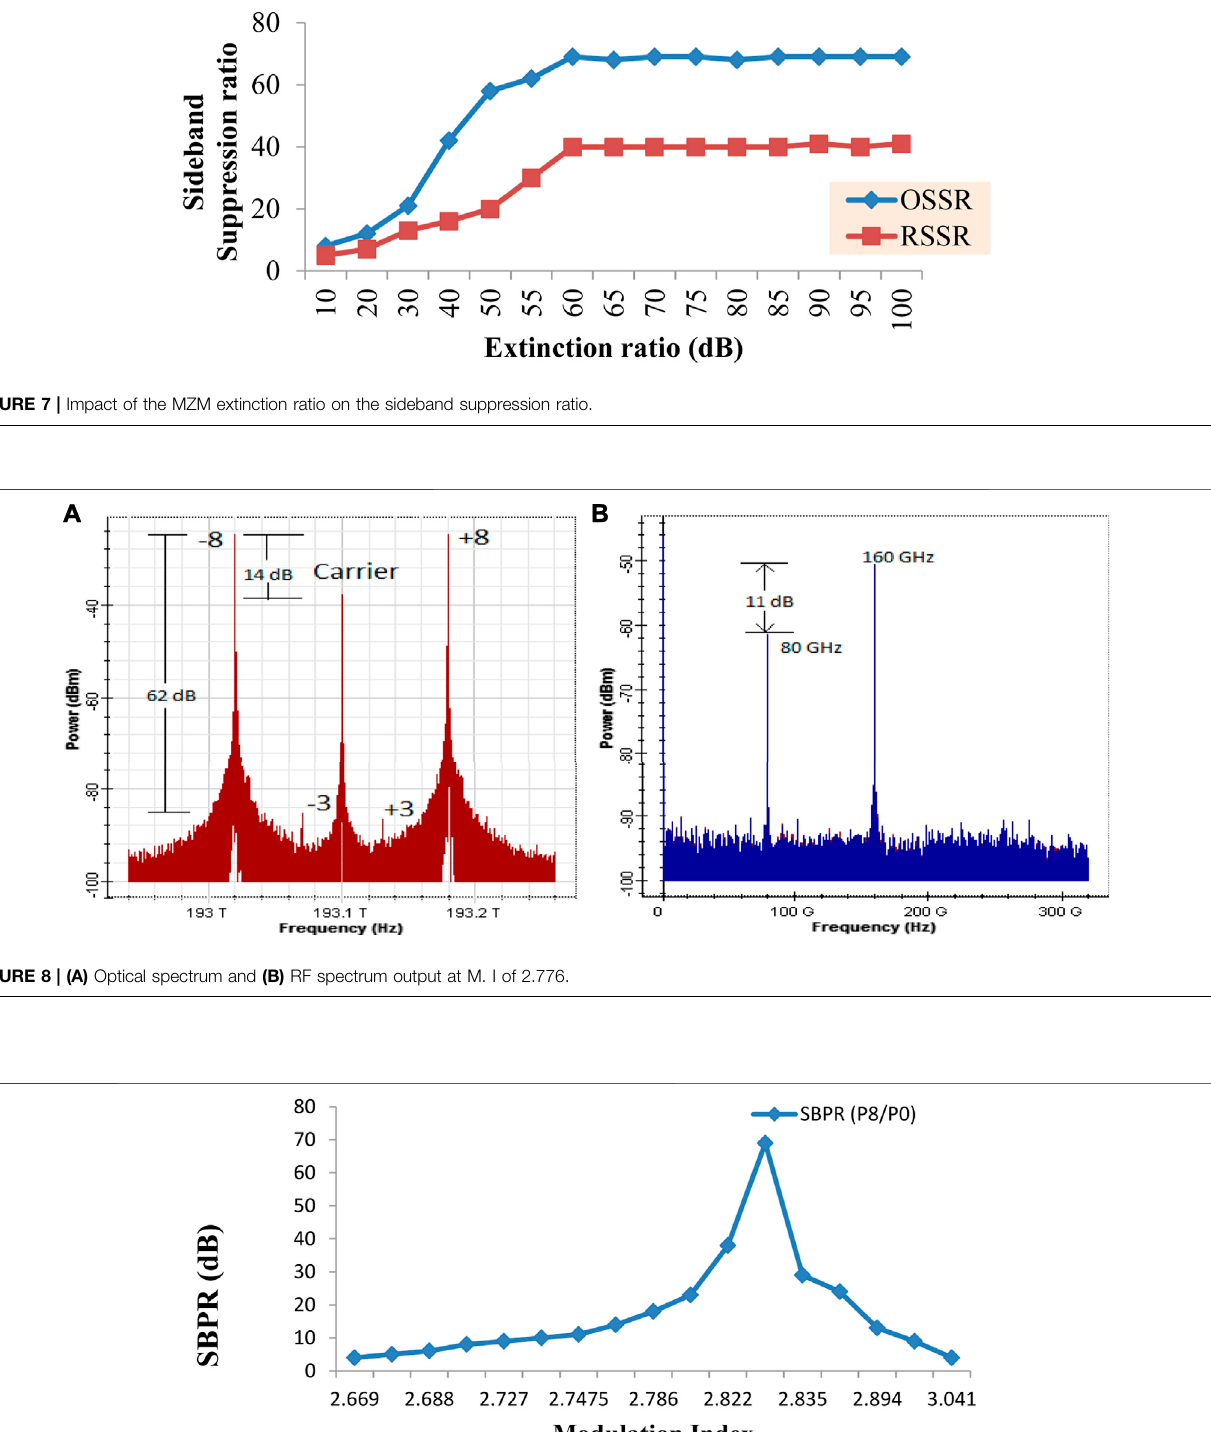
FIGURE 9 | SBPR variation with the modulation index.